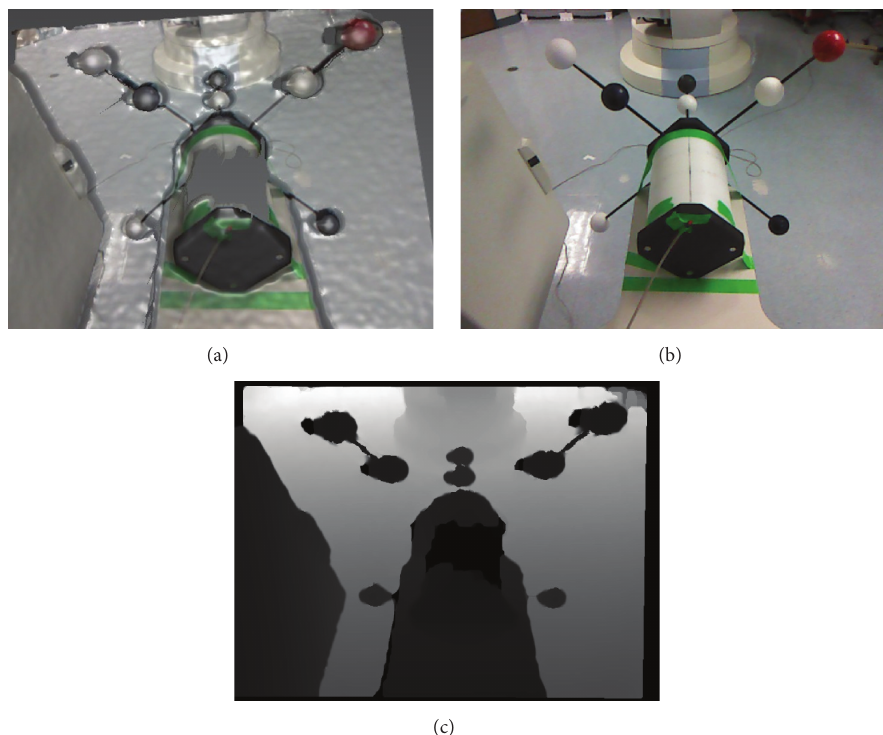
Figure 4: (a) shows an overlay of the depth and RGB data as captured by the Kinect camera. (b) and (c) show the separate RGB and depth images as used for this